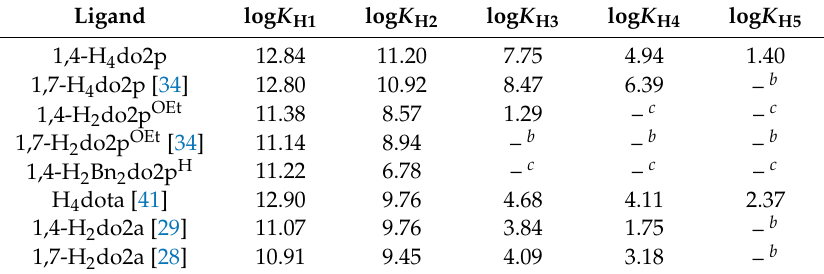
Table1. Stepwiseprotonationconstants a of1,4-H 4 do2p, 1,4-H 2 do2p OEt , and1,4-H 2 Bn 2 do2p H andother ligands discussed in the text (25 ◦ C, I = 0.1 m ).